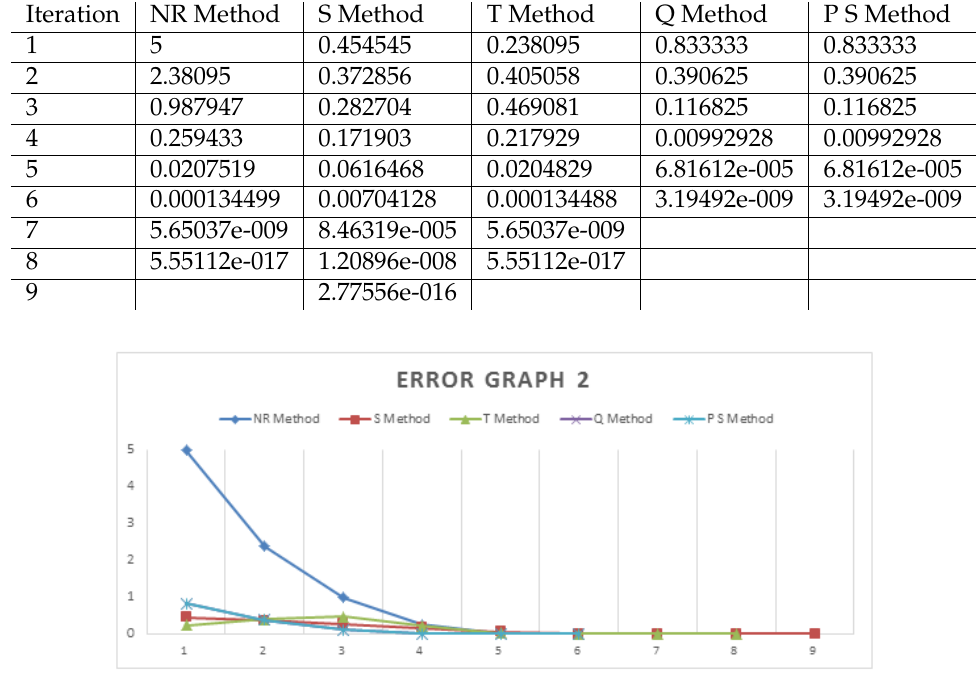
Table 4. Error analysis of NR Method, S Method, T Method, Q Method and P S Method for the Equation (19)